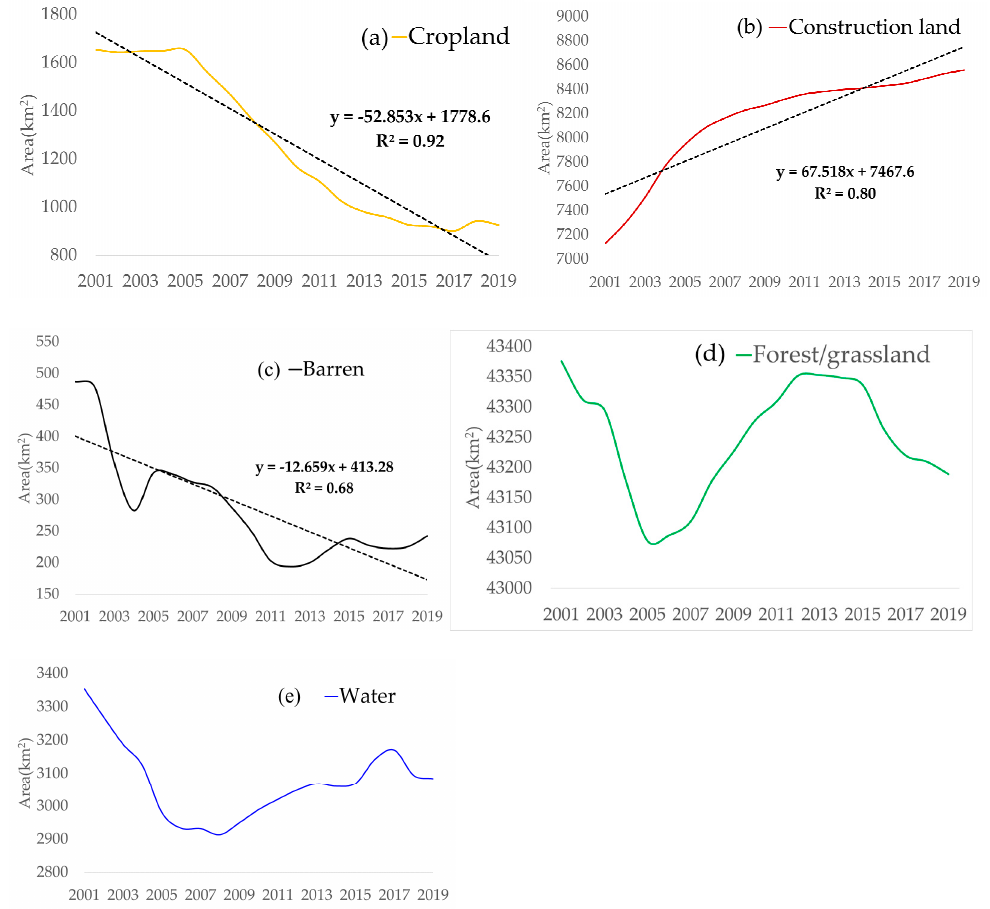
Figure 3. Land cover land use changed in the Greater Bay Area (GBA) from 2001 to 2019. ( a ) Cropland changed, ( b ) Construction land changed, ( c ) Barren changed, ( d ) Forest/grassland changed, ( e ) Water changed.